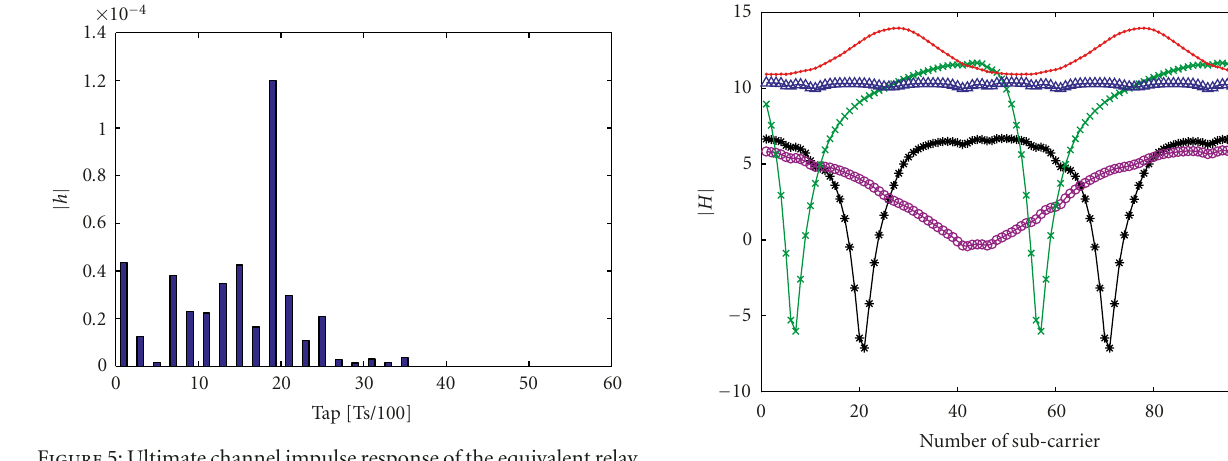
Figure 5: Ultimate channel impulse response of the equivalent relay channel.